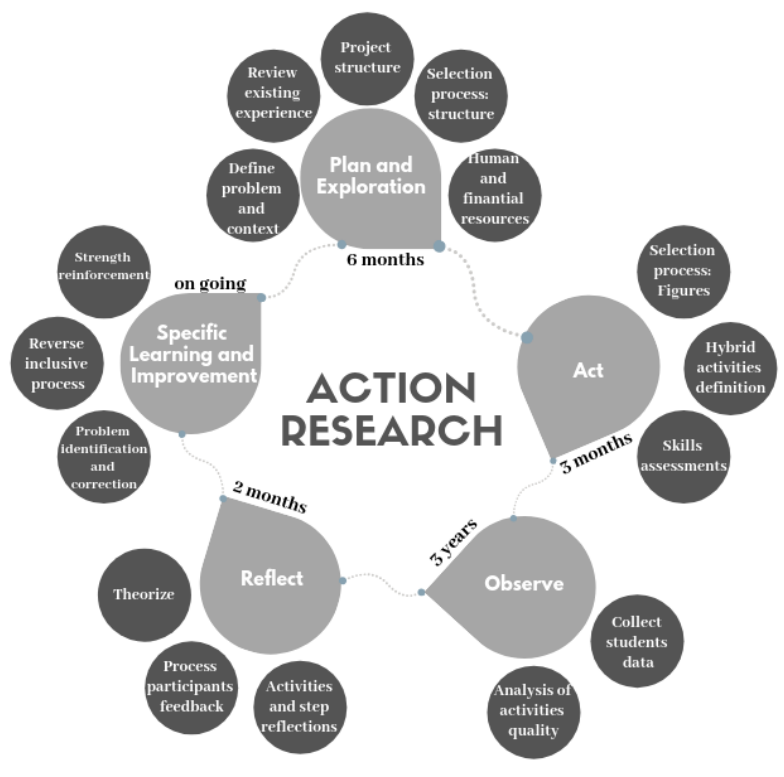
Fig. 1. Action Research cycle in